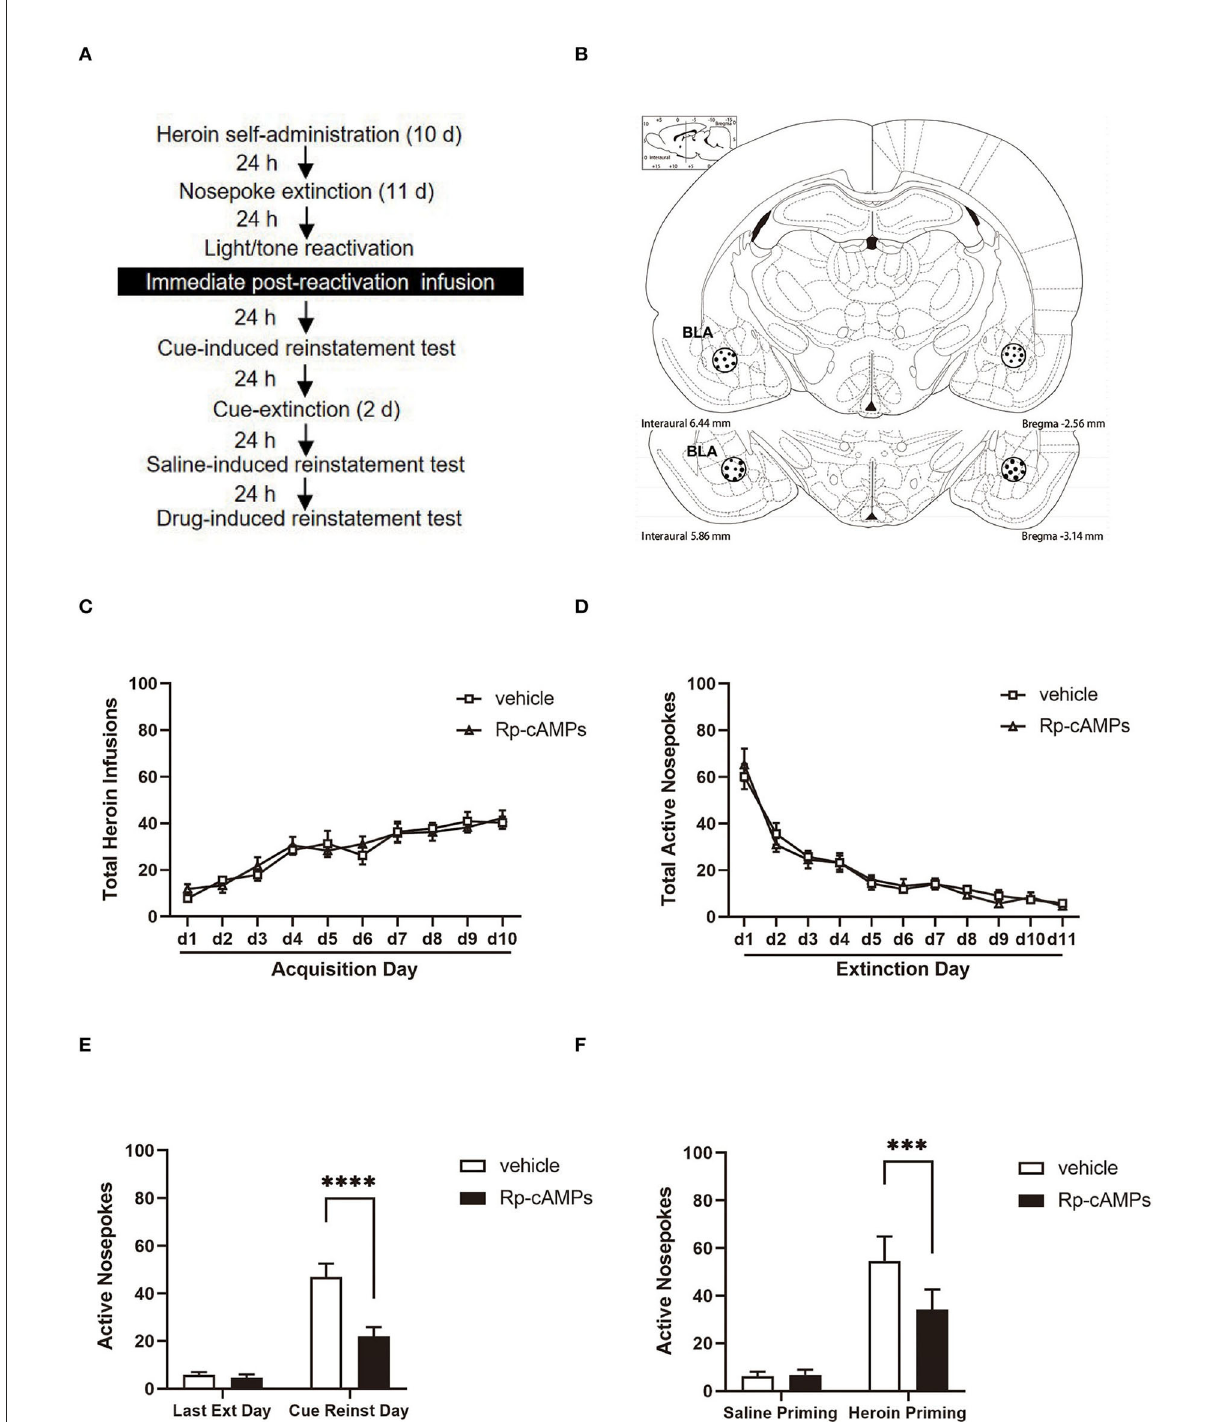
FIGURE1 The effect of immediately post-reactivation intra-basolateral amygdala (BLA) protein kinase A (PKA) inhibition on the subsequent cue- and heroin-induced reinstatement tests. (A) Timeline of the experimental procedure. (B) The regions of the basolateral amygdala (BLA: − 2.8mm from bregma) into which the cannula was placed as shown in the rostral faces of each coronal section. (C) The total number of infusions during the acquisition of heroin self-administration. (D) The total number of active nosepoke responses during extinction sessions. (E) Active nosepoke responses during the last day of extinction and the cue-induced reinstatement test. (F) Active nosepoke responses during the saline- or heroin- primed reinstatement test. The value of n = 8 rats per group. Data are means ± SEM, *** p < 0.001, **** p < 0.0001, compared with the vehicle group. Ext, extinction; Reinst,